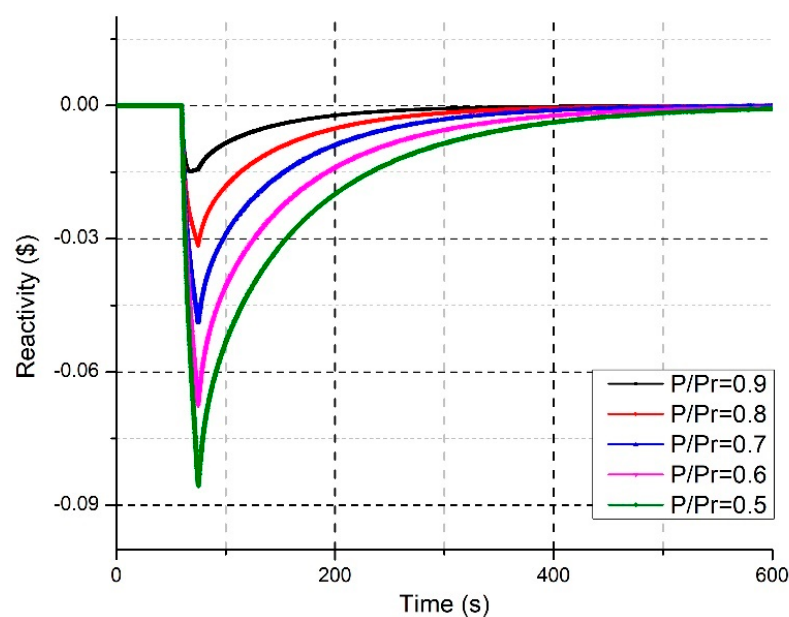
ff erent power Figure 16. Power level operation for different power levels. Figure 16. Power level operation for di Figure 16. Power level operation for different power levels.